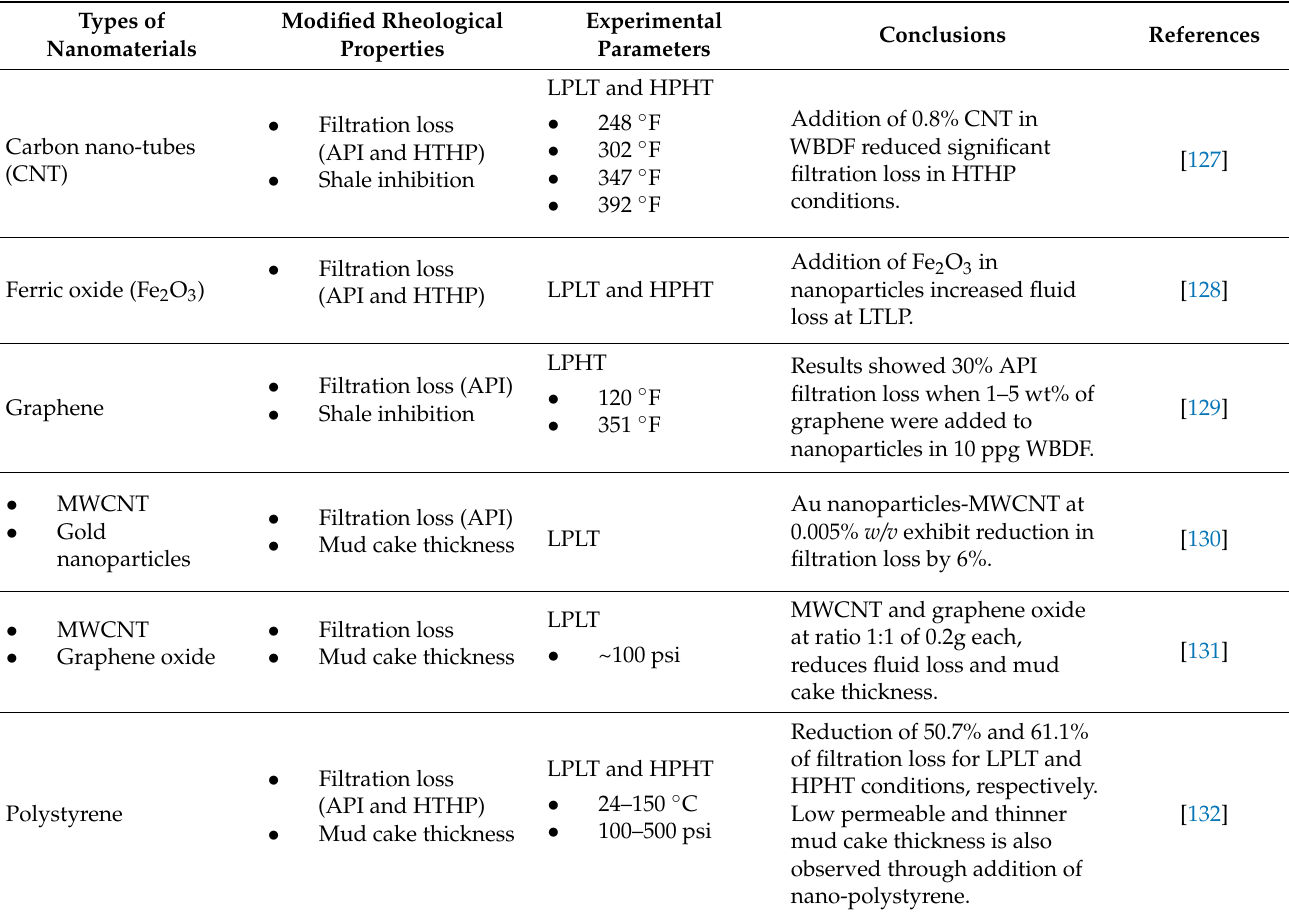
Table 2. Literature studies on the effects of nanomaterials as fluid loss agents in drilling fluids. Types